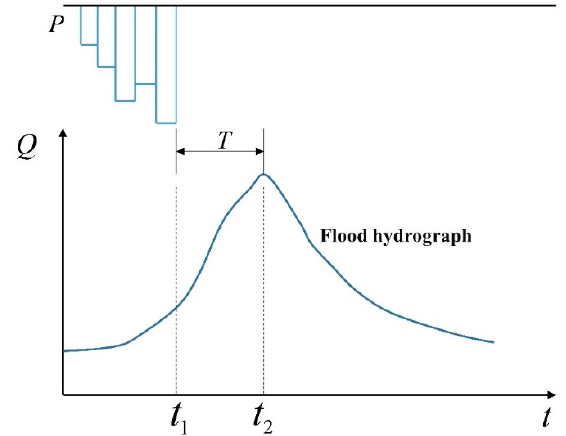
Figure 2. Natural forecast lead time of a flood. Note: P is the precipitation; T is the flood forecast t is the end time of the main rainfall; and lead time; 1